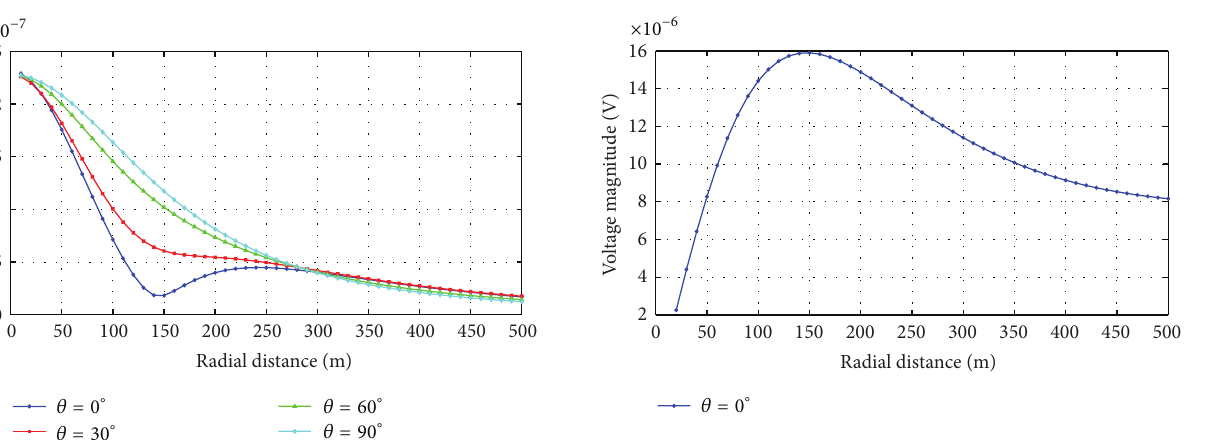
Figure7:Curveofthevoltagereceivedonthegroundwiththeradial